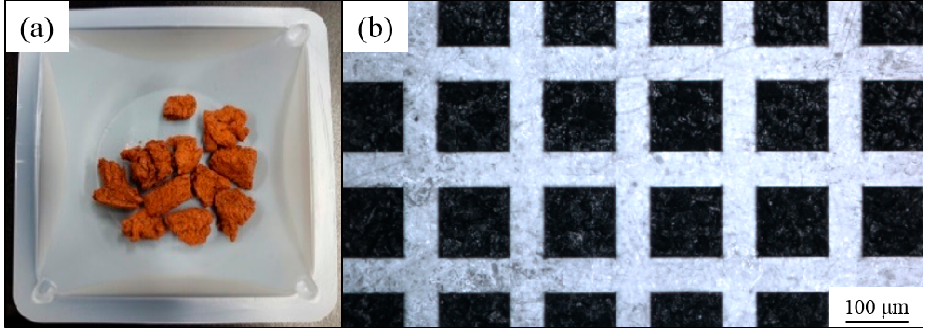
Figure 4. ( a ) Fabricated feedstock; ( b ) polymethylmethacrylate (PMMA) sacrificial mold.